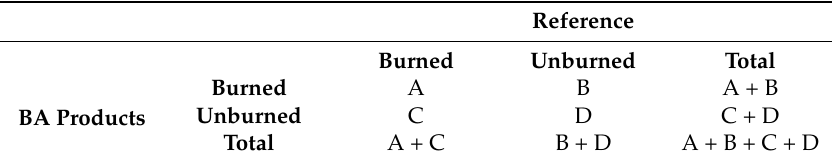
Table 2. Generic contingency table between the reference and burned area (BA) products.